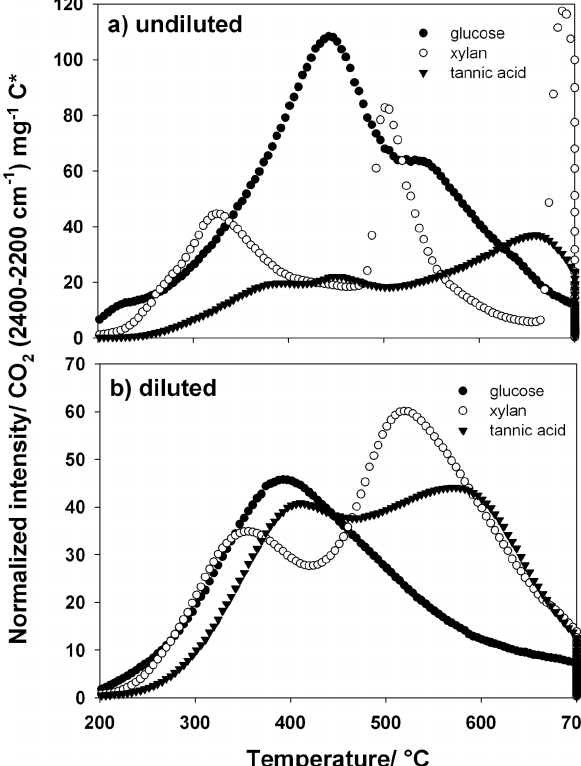
Figure 4 Fig. 4. FTIR-EGA CO 2 thermograms of three selected substances. (a) neat samples, (b) diluted 1 : 100 with preheated, ball-milled quartz sand. ∗ Normalized intensity is the integrated area of the CO 2 peak from 2400 to 2200cm − 1 normalized to C content of the